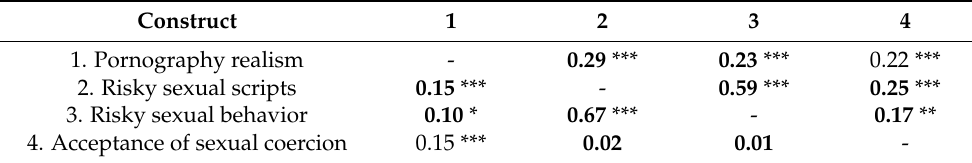
Table 2. Bivariate correlations between the predictor